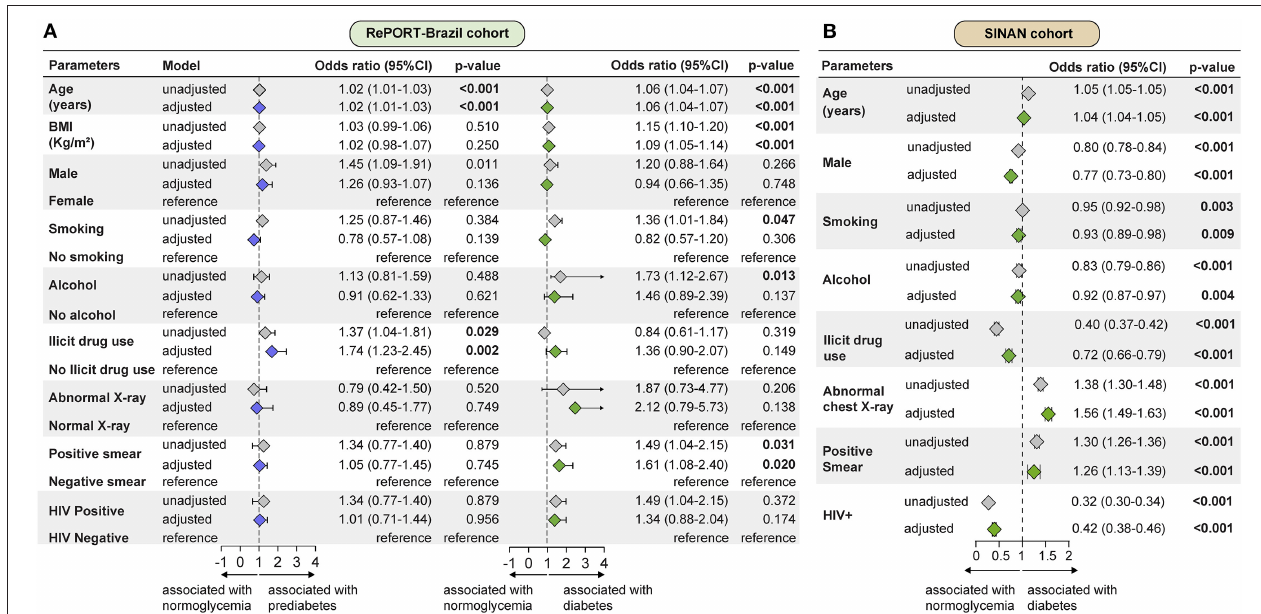
FIGURE 2 | Factors associated with dysglycemia in patients with active pulmonary tuberculosis in RePORT-Brazil and SINAN cohorts. (A) A multinomial logistic regression analyses were used to test association between indicated characteristics of pulmonary TB patients and presence of prediabetes (left panel) or diabetes (right panel). Variables included in the adjusted model exhibited univariate p -values ≤ 0 · 2 (See Supplementary Table 2 for details). (B) Binomial logistic regression to test association between indicated characteristics of TB patients and presence of diabetes. Only variables with significant p-value in the adjusted model are shown. Variables included in the adjusted model exhibited univariate p -values ≤ 0.2 (See Supplementary Table 3 for details). BMI, Body Mass Index.